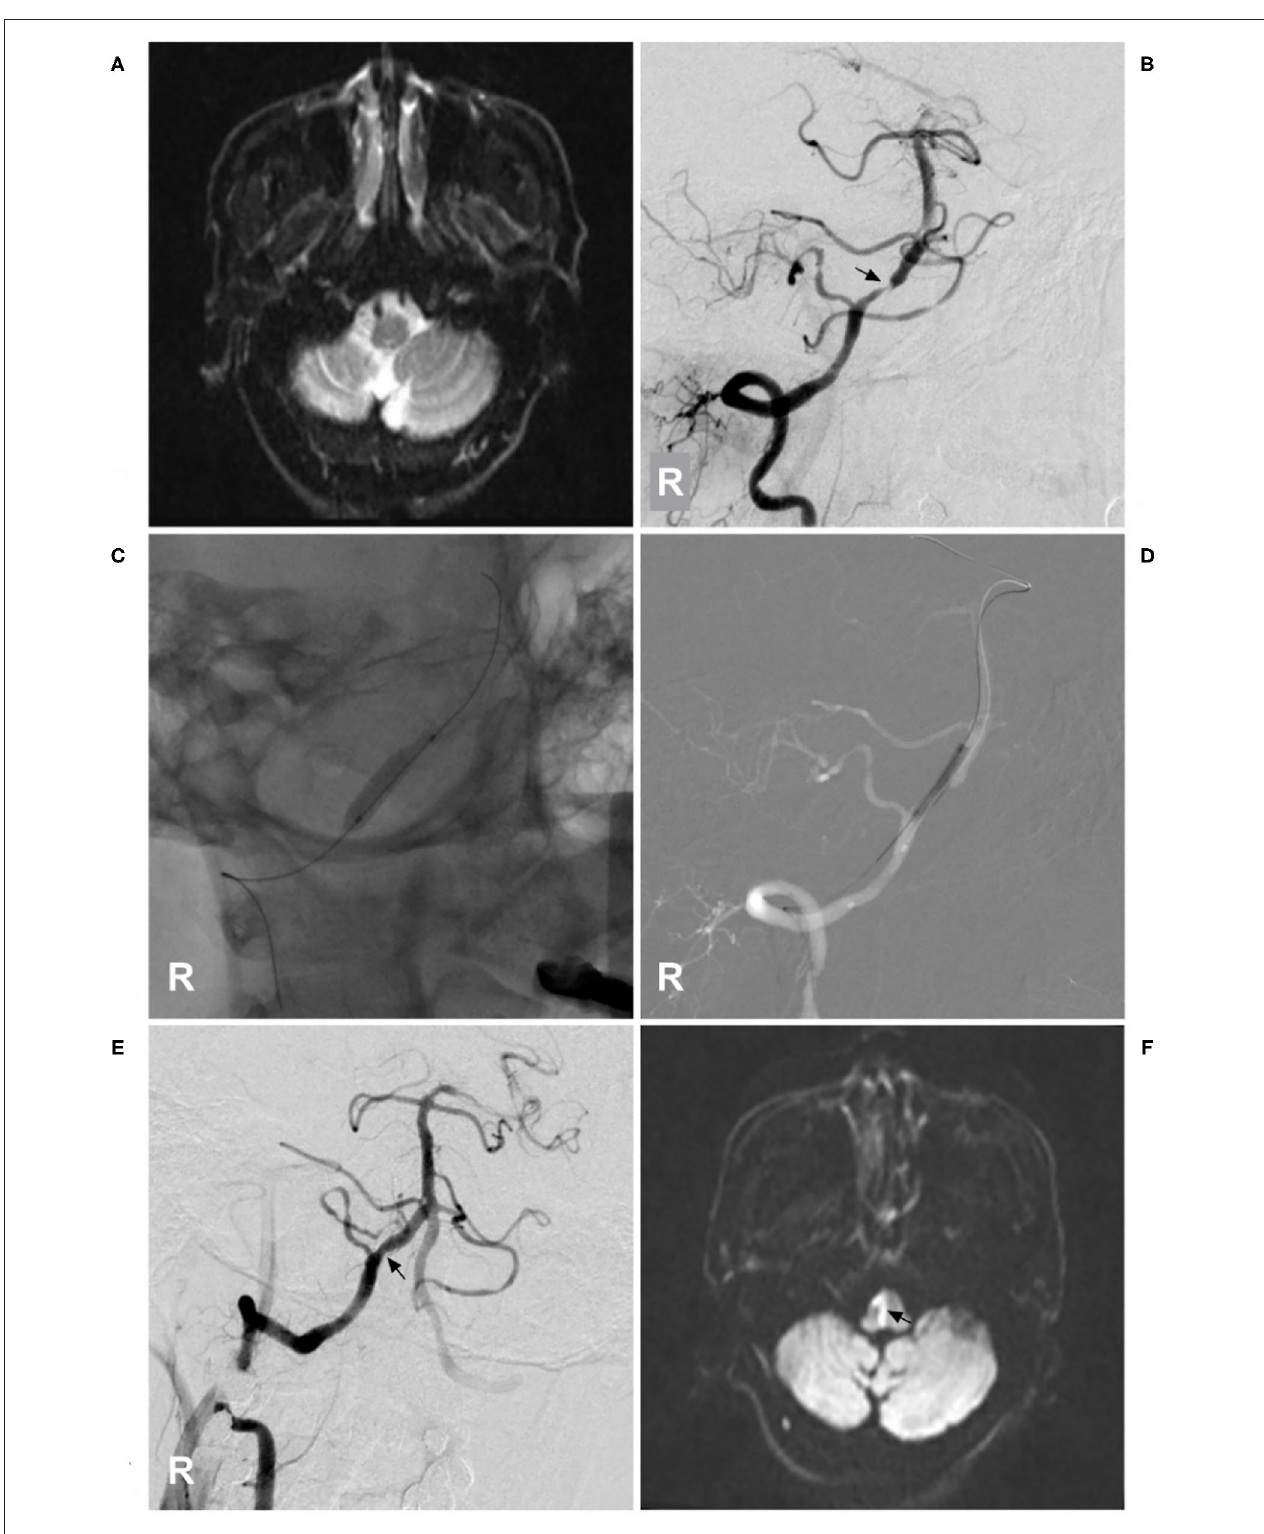
FIGURE 7 | Medulla oblongata infarction from ASA ischemia after stent angioplasty. (A) MRI showed a normal medulla oblongata. (B) A right VA angiogram showed stenosis (arrow) of the VA beyond the posterior inferior cerebellar artery. (C) Balloon angioplasty was performed. (D) A balloon-expandable stent was deployed. (E) After stent angioplasty, the stenosis was relieved (arrow). (F) Postoperative MRI showed acute medulla oblongata infarction (arrow), indicating ASA ischemia and resulting in locked-in syndrome. ASA, anterior spinal artery; MRI, magnetic resonance imaging; R, right; VA, vertebral artery.